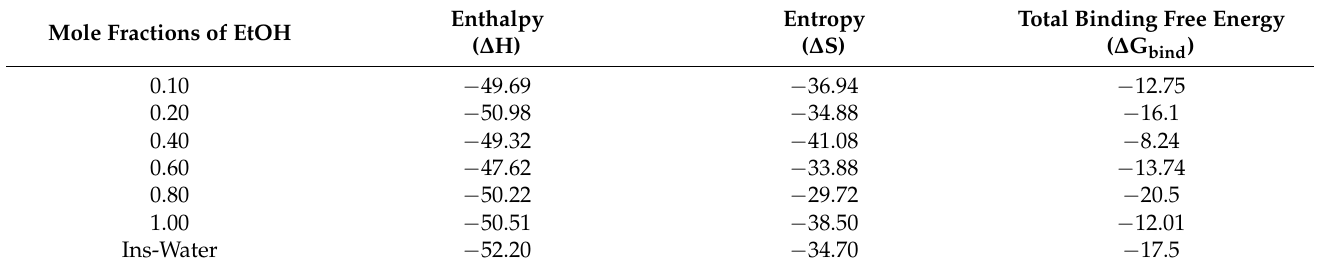
Table 3. The binding free energy of insulin dimerization with different mole fractions of EtOH. Enthalpy, entropy, and binding free energies are indicated in